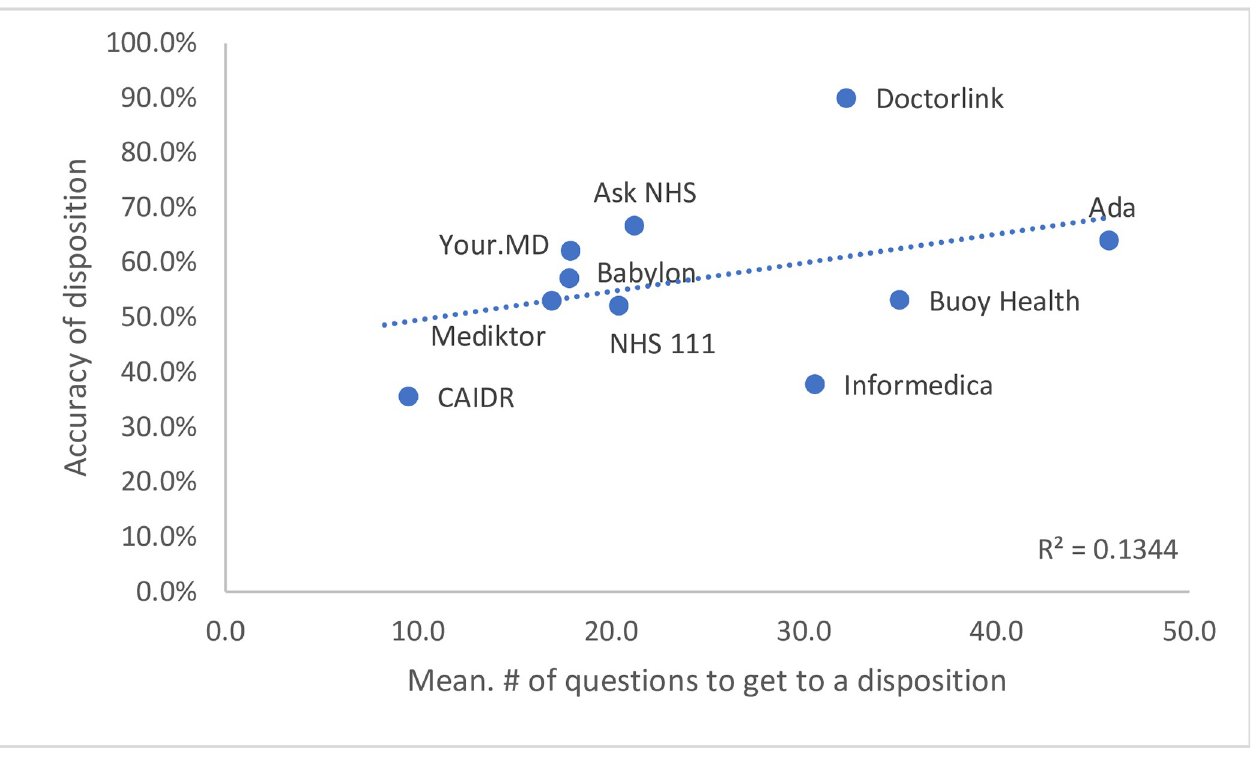
Fig 3. Correlation of mean number of questions to triage